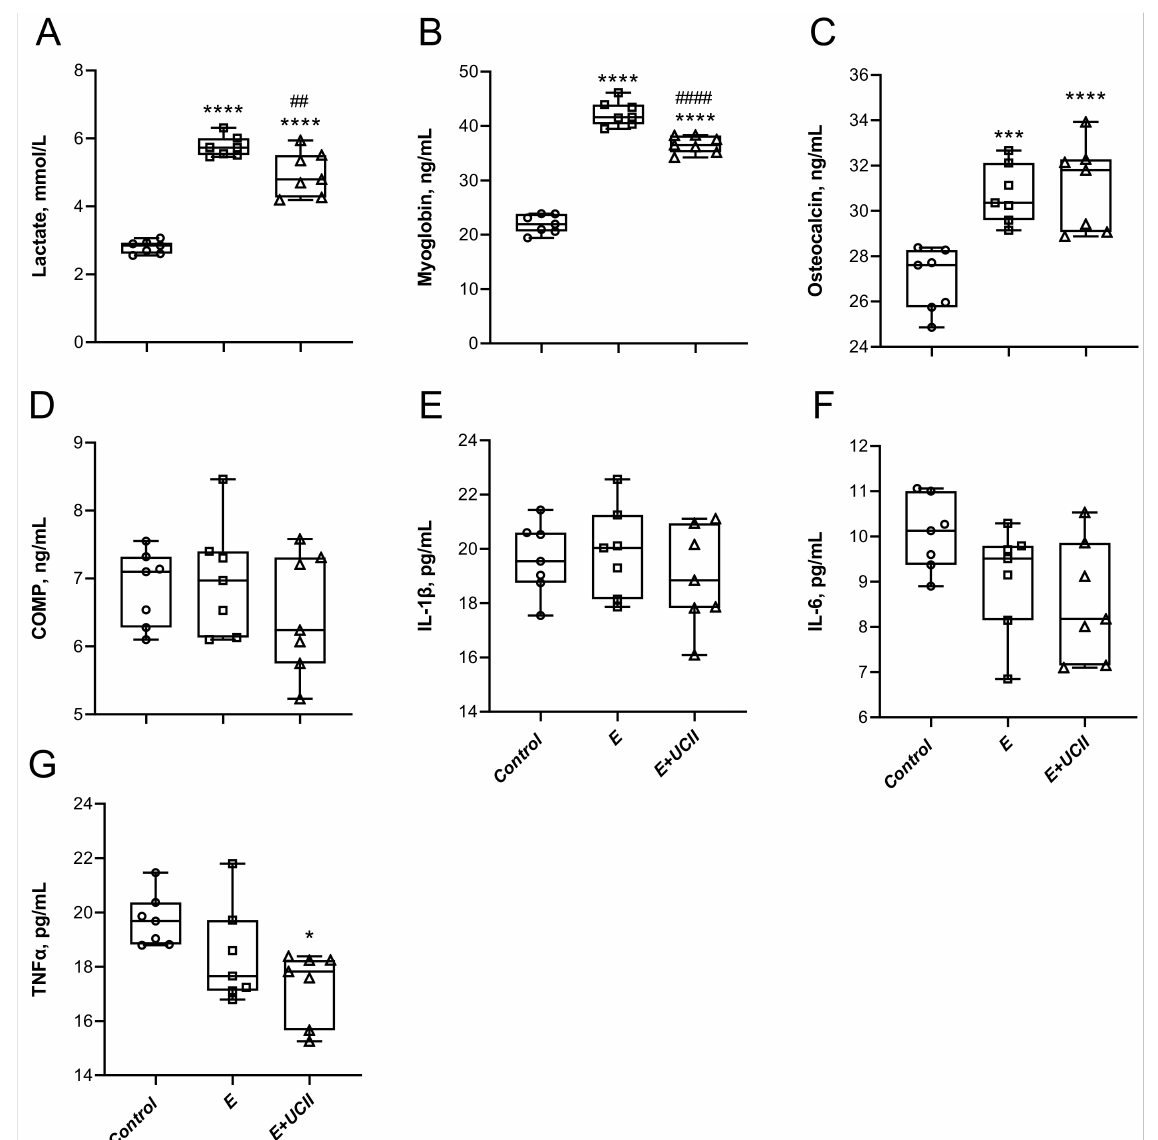
Figure 2. The effect of UCII on the serum lactate ( A ), myoglobin ( B ), osteocalcin ( C ), COMP ( D ), IL-1 β ( E ), IL-6 ( F ), and TNF α ( G ) levels in exercised rats. Box and Whisker plots show median, min, and max values. ANOVA and Tukey’s post-hoc test were used to compare the results among different treatment groups. Statistical significance between groups is shown by: * p < 0.05, *** p < 0.001, **** p < 0.0001 compared as control group and, ## p < 0.01, #### p < 0.01 com-pared as exercise Group. UCII, Undenatured type II collagen; COMP, cartilage oligomeric matrix protein; IL-1 β , interleukin-1 β , IL-6, interleukin-6; TNF α , tumor necrosis factor-alpha. Control (Circle): no exercise and no UCII, E (Square): exercised rats, E + UCII (triangle), exercised rats receiving 4 mg/kg BW/day